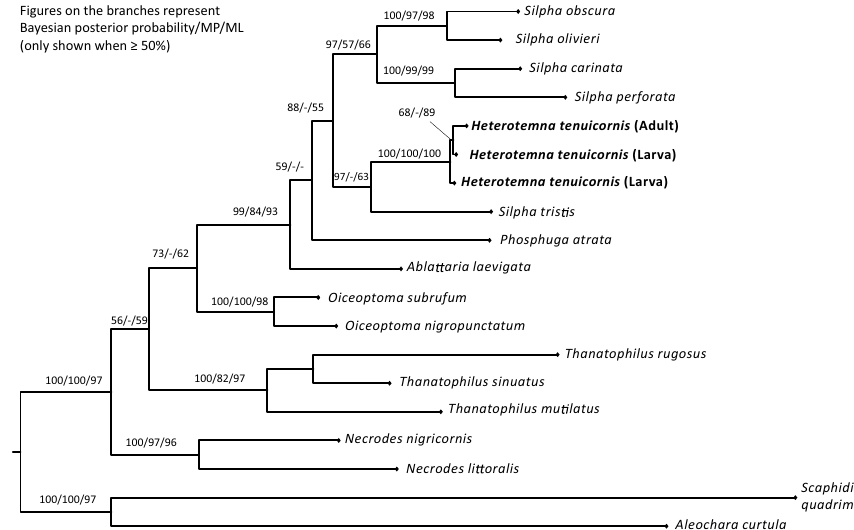
Figure 1. Phylogenetic tree based on Bayesian analysis. Numbers above branches show the posterior probability and bootstrap values (BI)/maximal parsimony (PAUP)/Maximum likelihood (MEGA).